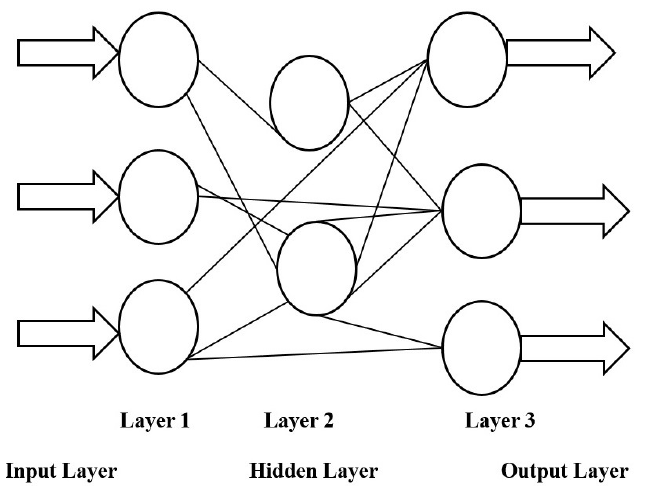
Figure 2. A basic deep feed-forward network.